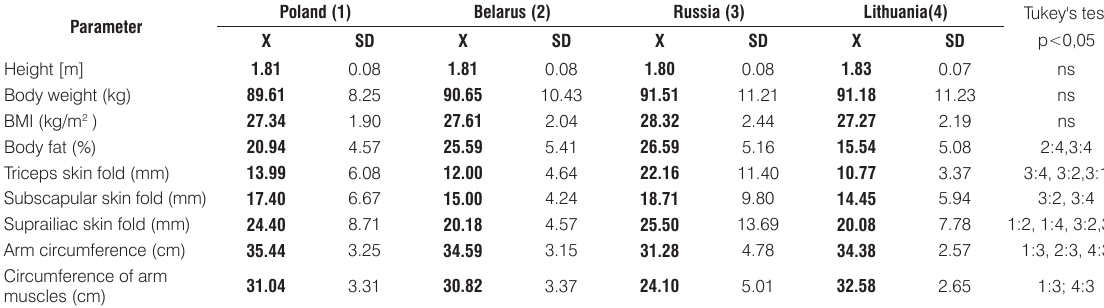
Table 3. Anthropometric characteristics of male students with BMI > 25 kg/m 2